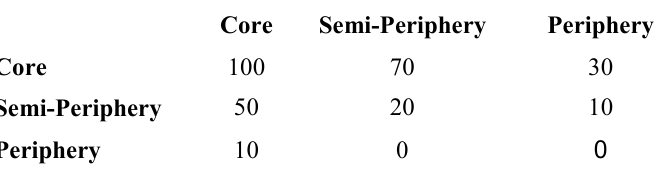
Table 1: Ideal-Typical Core / Periphery